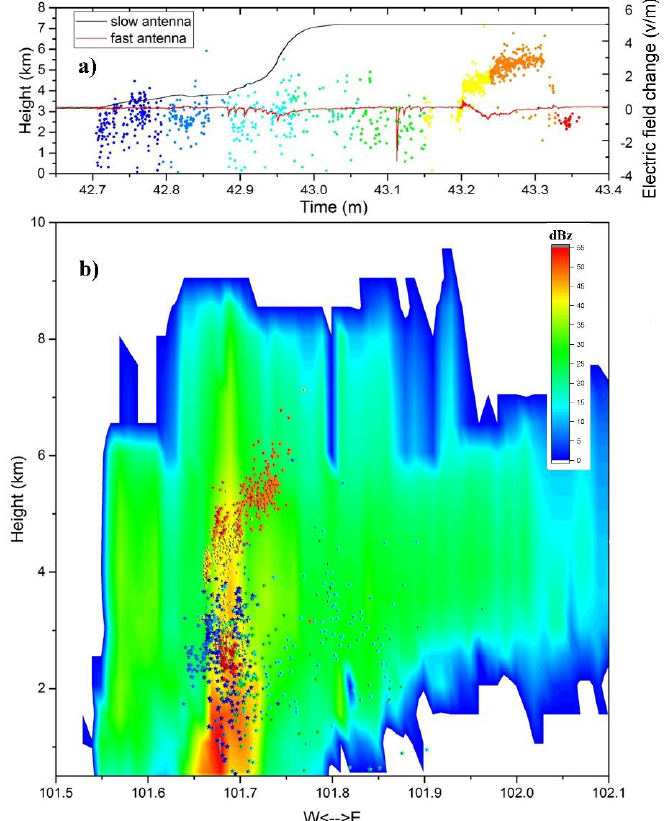
Figure 12. Fast and slow electric field change waveforms of negative ground flash No. 141942 and the positioning results of the VHF radiation sources compared with the radar echo. ( a ) Height-time plots and electric field change waveforms; ( b ) North-Southward vertical projection superimposed by vertical section of radar